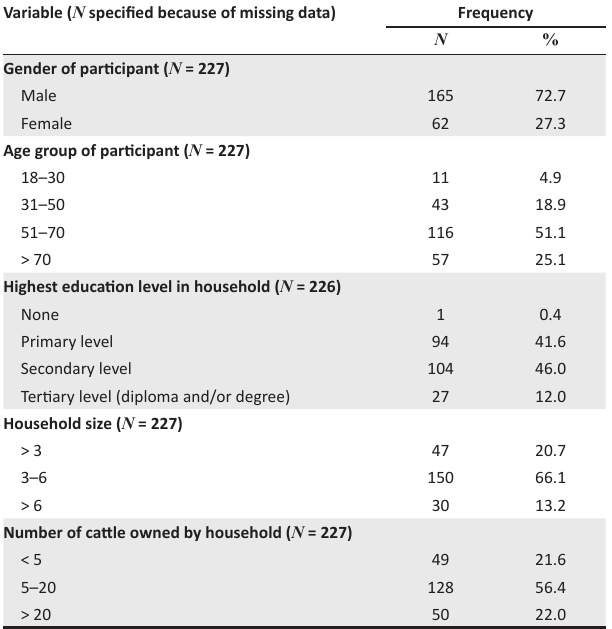
TABLE 2: Knowledge of brucellosis among participants that reported having heard about the disease, Whittlesea community, South Africa, 2017 (reflecting the outcome of some of the knowledge